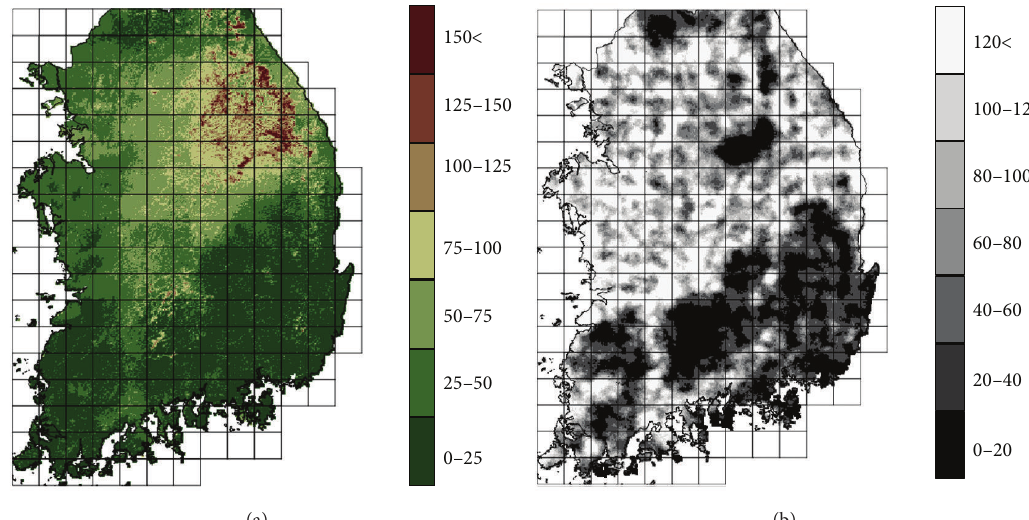
Figure 7: Summary statistics values computed from 50 simulations: (a) E-type estimate and (b) conditional